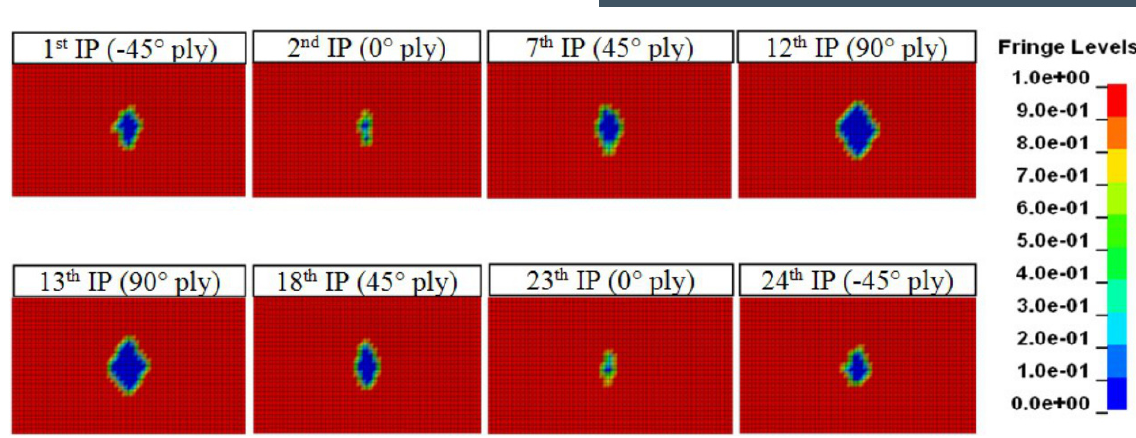
Figure 6. Contour of tensile matrix mode failure ( e m ) at different integration point in one TSHELL model at peak load (2.9 ms). IP = integration point.